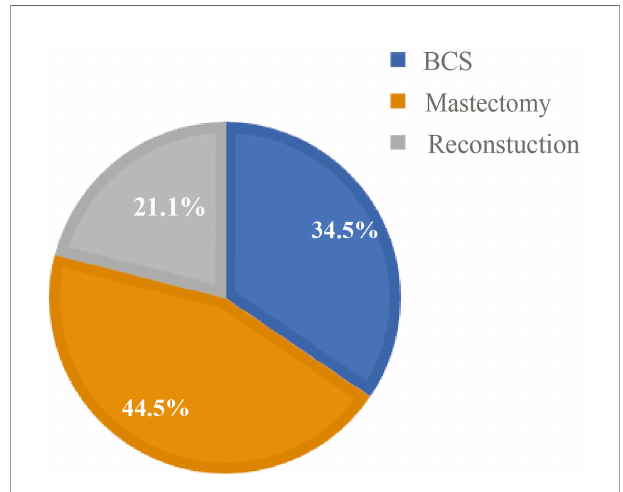
FIGURE 2 | Percentage of surgical options in young patients at Fudan University Shanghai Cancer Center